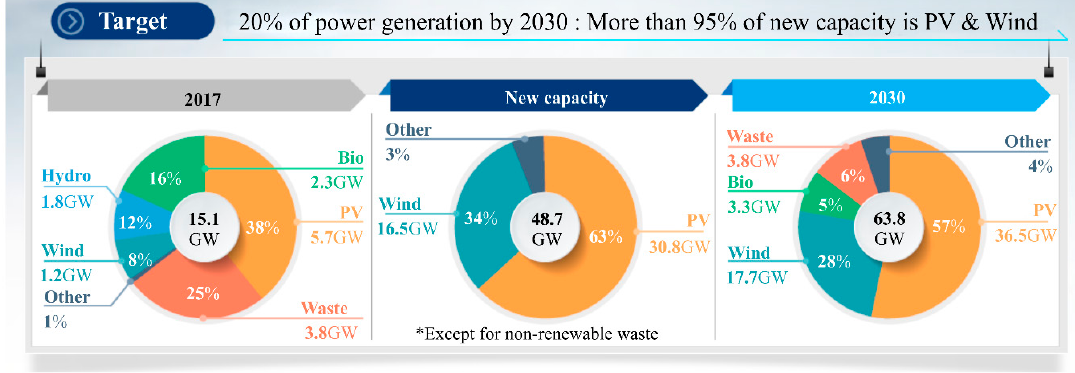
Figure 2. Roadmap for renewable energy generation by 2030 in Korea.